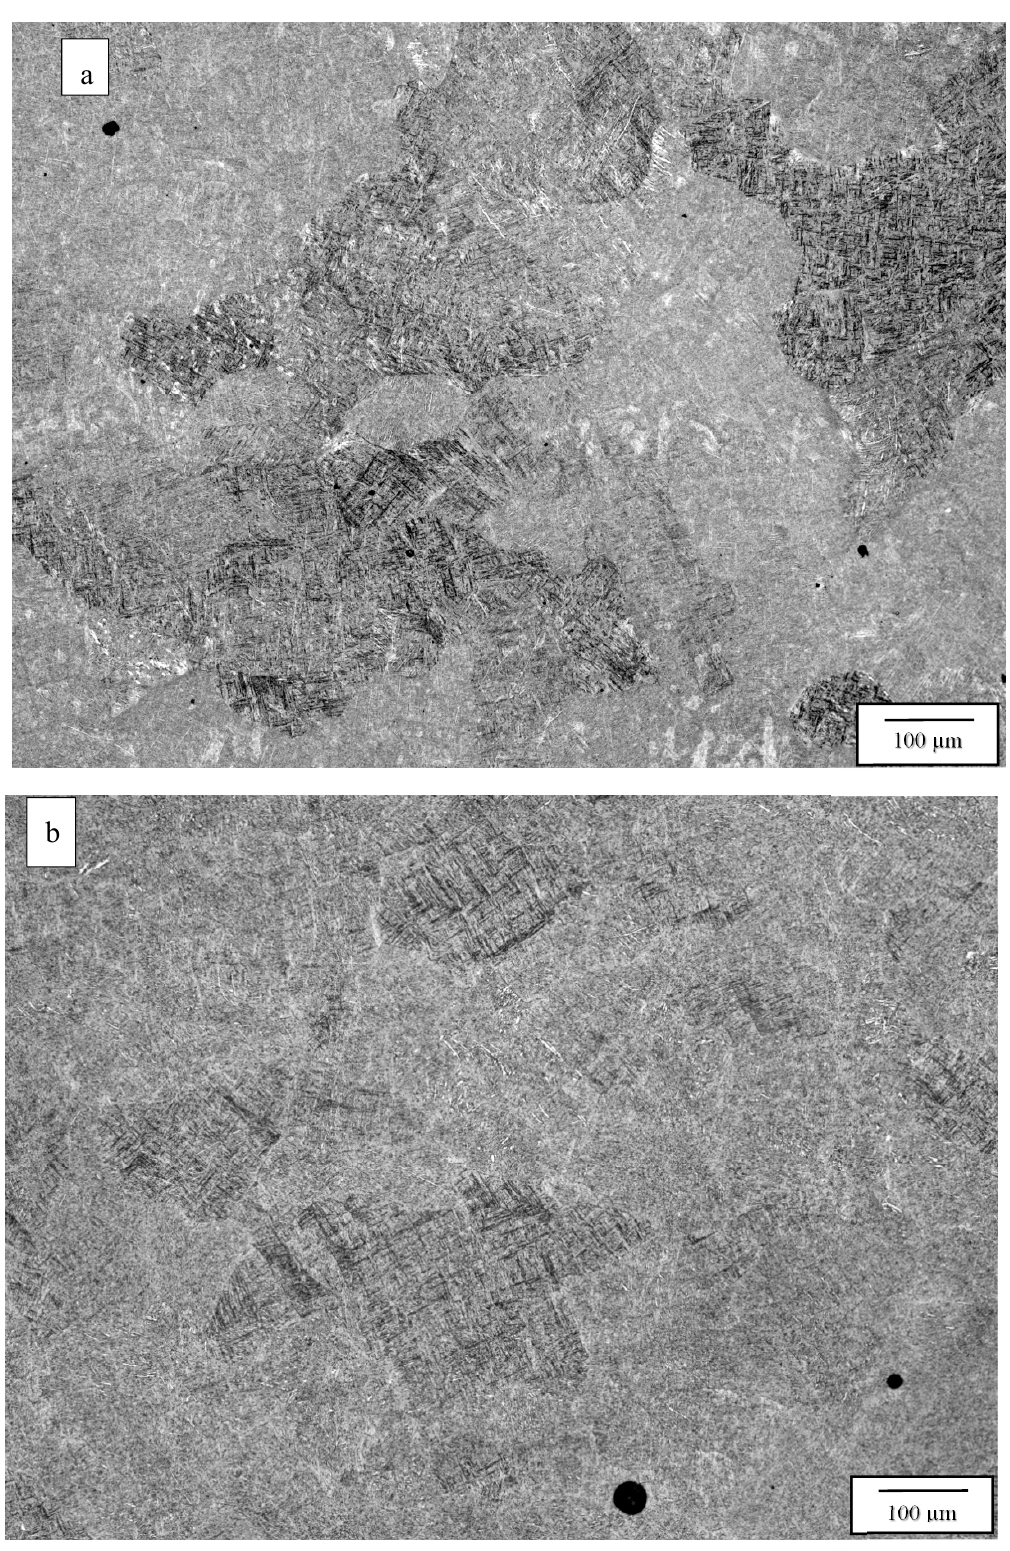
Figure 3. Variants 1 (as-fabricated) optical metallograph images for the Arcam A2X ( a ), and Q20 ( b ) top section, X plane.